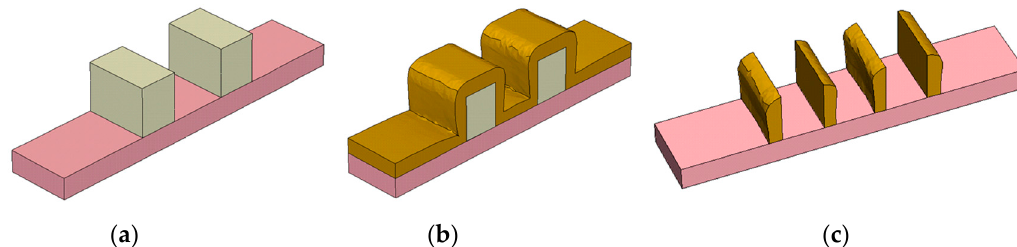
Figure 7. Example for the simulation of Self-Aligned Double Patterning: ( a ) carbon lines patterned by optical lithography; ( b ) layer deposition; ( c ) spacer pattern after back etching.